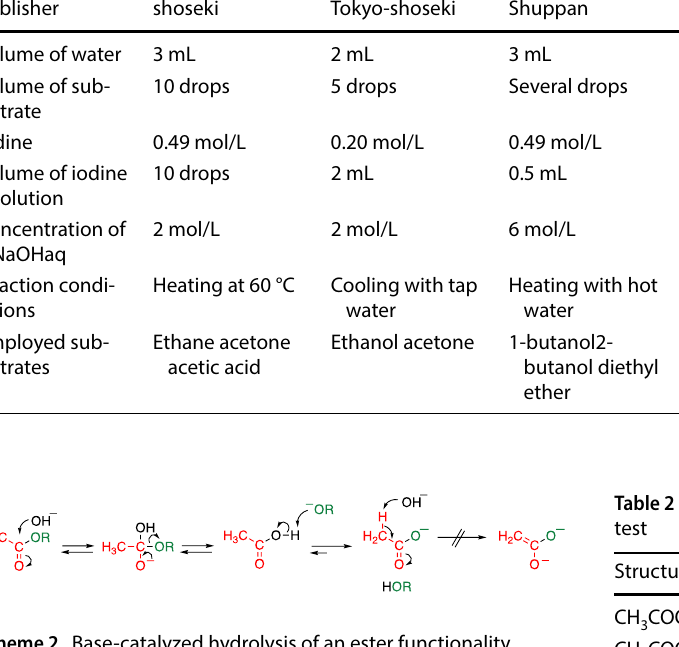
Table 1 Reaction conditions for the iodoform test in high school textbooks in Japan Textbook and Publisher